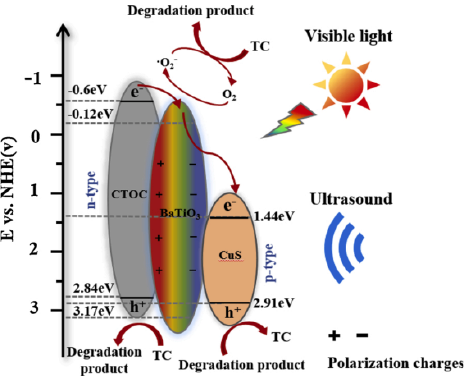
Figure 17. Mechanism for the photo/piezo-catalysis process of CTOC/BaTiO 3 /CuS composites under visible-light irradiation (Reprinted/adapted with permission from Ref. [174]. Copyright 2021, copyright Elsevier).